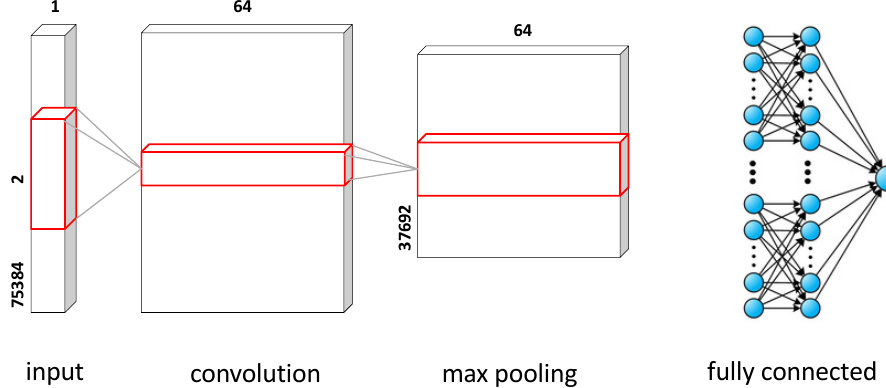
Figure 5. Our proposed 1DCNN